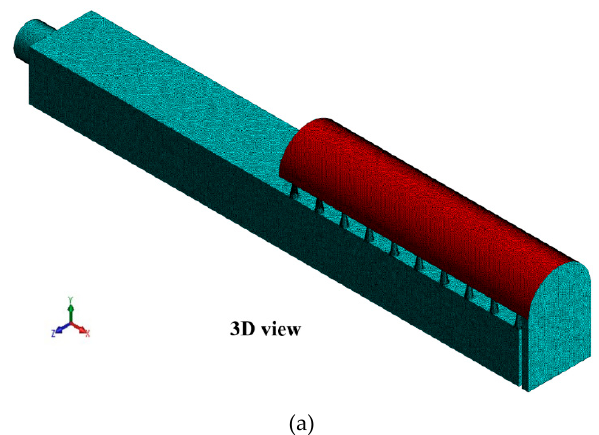
Figure 6. Spanwise averaged Nusselt number for both experimental and numerical results of impingement cooling at ( a ) Re noz = 5000, ( b ) Re noz = 15,000 and ( c ) Re noz =